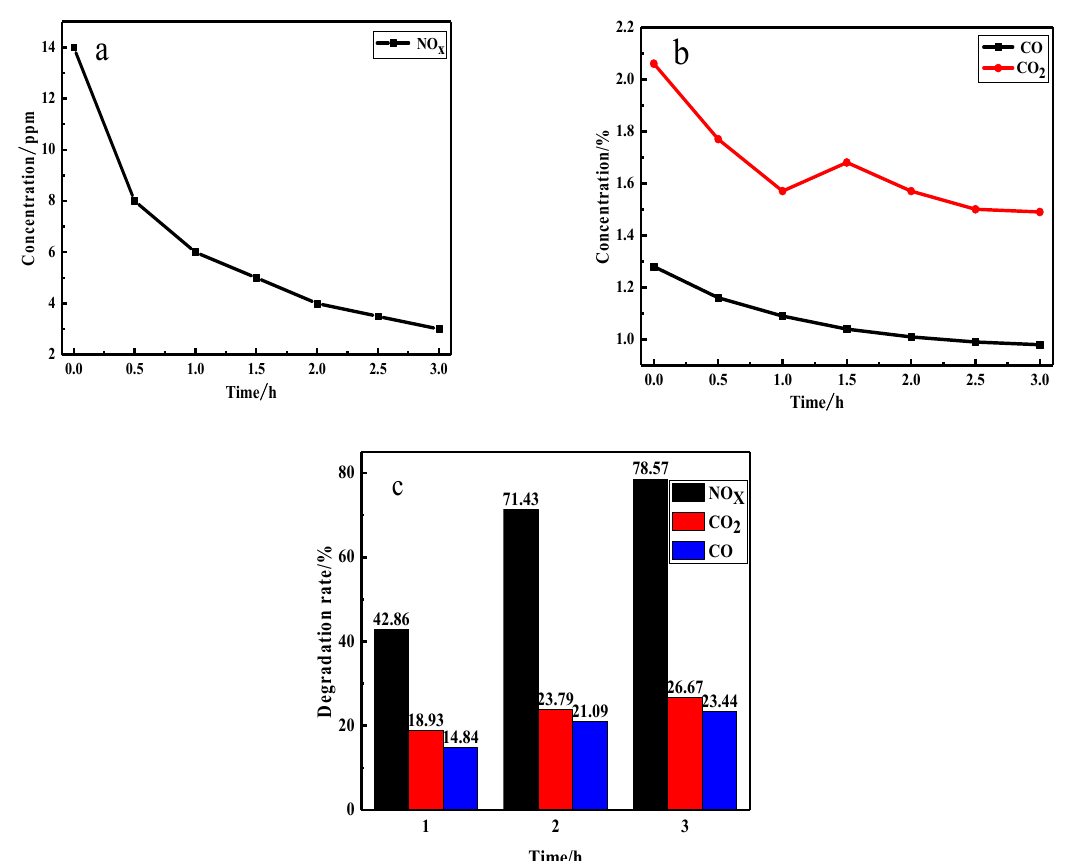
Figure 9. The concentrations of NO x , ( a ) and CO and CO 2 ( b ) during the photocatalytic reaction process, and the photocatalytic degradation rate of VE ( c ) by doped TiO 2 under visible light.